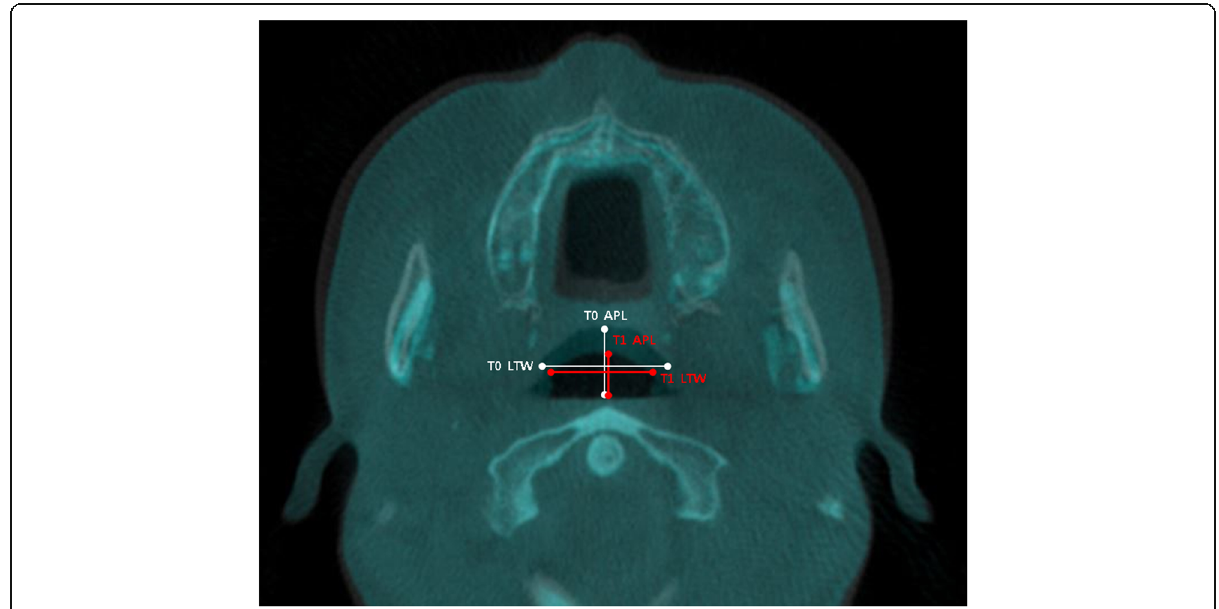
Fig. 2 Evaluation of the pharyngeal airway changes. The largest transverse width ( LTW ) and anteroposterior length ( APL ) on each axial plane (CV1, CV2, CV3) were measured at T0 and T1